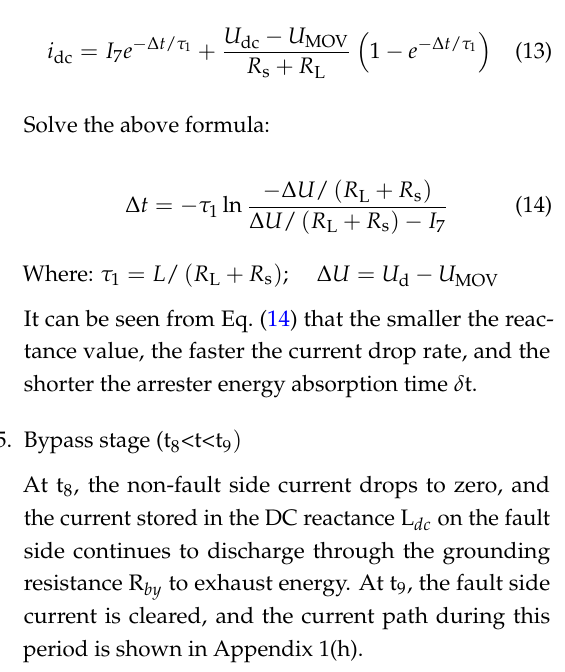
Fig. 4. RFL-HDCCB normal closing circuit